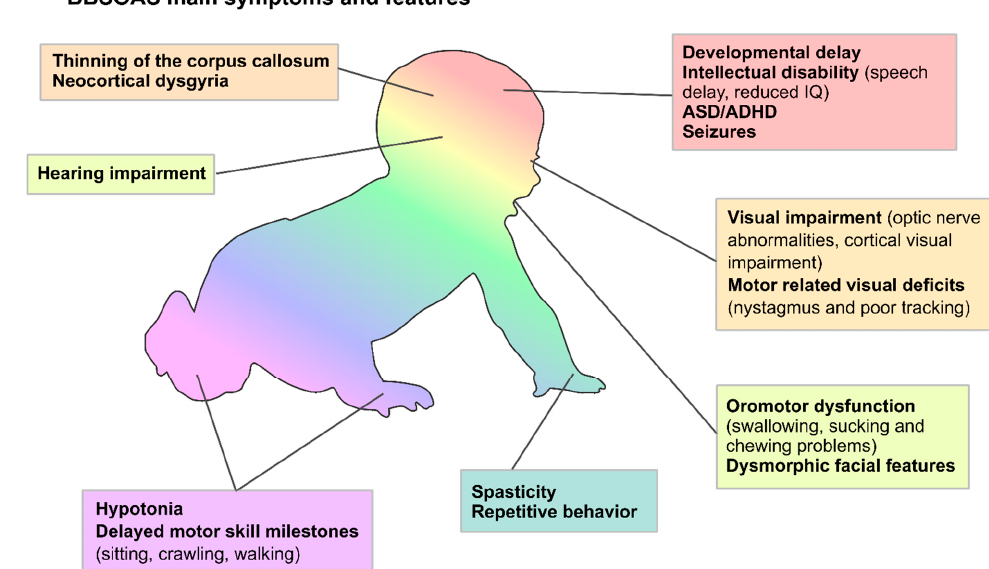
Figure 2. BBSOAS clinical spectrum . List of main BBSOAS symptoms and features, subdivided by affected systems. While developmental delay, intellectual disability and optic atrophy are the most common features (88%, 85.9% and 66.3% of patients, respectively), other symptoms are less common, such as CVI (44.6%), epilepsy (46.7%), ASD or autistic traits (39.1% and 14.1%, respectively), hearing impairment (11%) and hypotonia (62%). Abbreviations: ADHD, attention deficit hyperactivity disorder; ASD, autism spectrum disorder; CVI, cortical visual impairment; IQ, intelligence